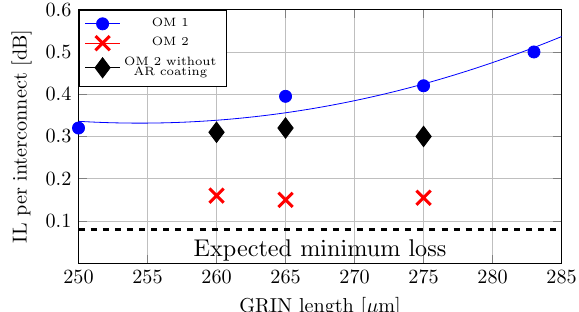
Figure 5. Insertion loss of SMF-28-NANF interconnect using OM1 (AR coated, blue circles, solid blue line represents fitted measurement data) and OM2 with (red crosses) and without (black diamonds) AR coating GRIN MFAs.